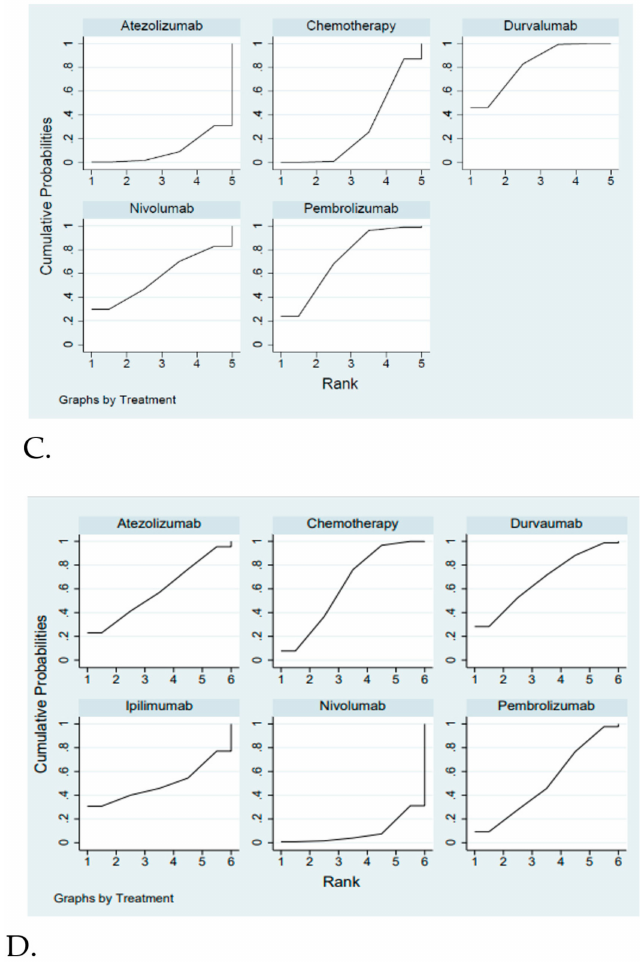
Figure 4. Cumulative ranking probability for di ff erent treatments. ( A ) Overall survival; ( B ) Progression free survival; ( C ) Objective response rate; ( D ) Grade 3–4 adverse events.